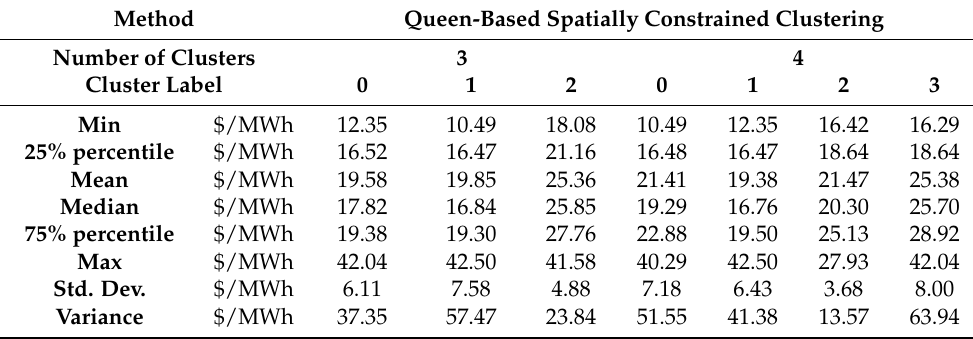
Table 2. Statistical measures of queen-based spatially constrained